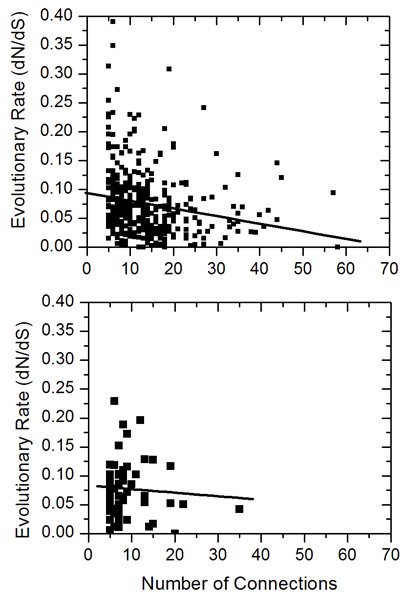
The correlation between interactions and evolutionary rates of star core proteins and k-plex core proteins. A) The correlation between interactions and evolutionary rates of k-plex core proteins. The correlation observed is -0.1934. B) The correlation between interactions and evolutionary rates of the star core proteins. The correlation observed is -0.0688.